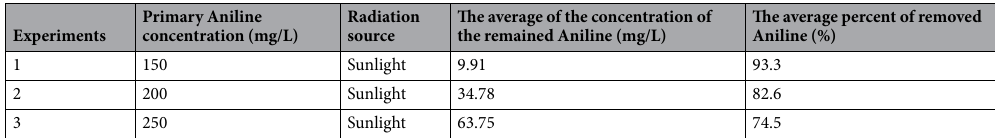
Table 3. The primary concentration and the remained Aniline after the photo-oxidation